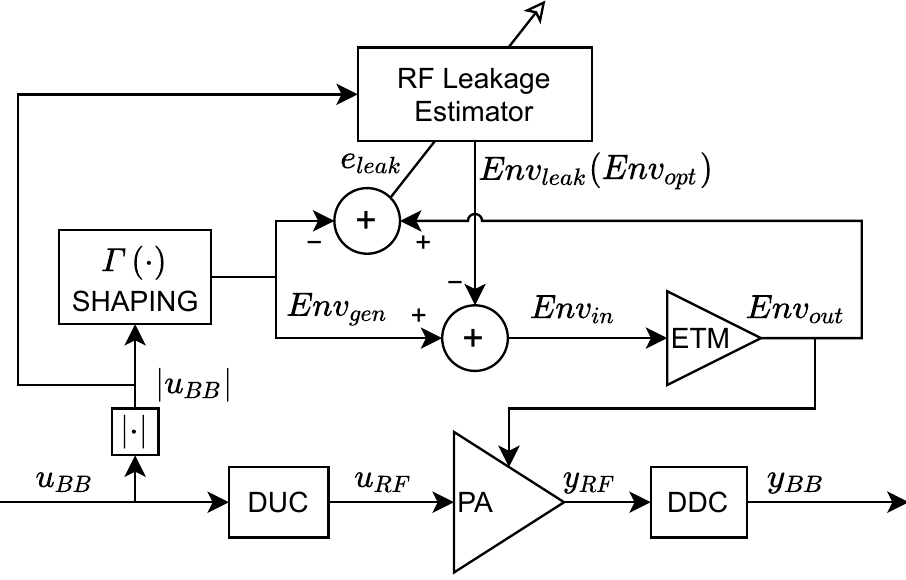
Figure 6. Block diagram of the RF leakage compensation and its coefficient